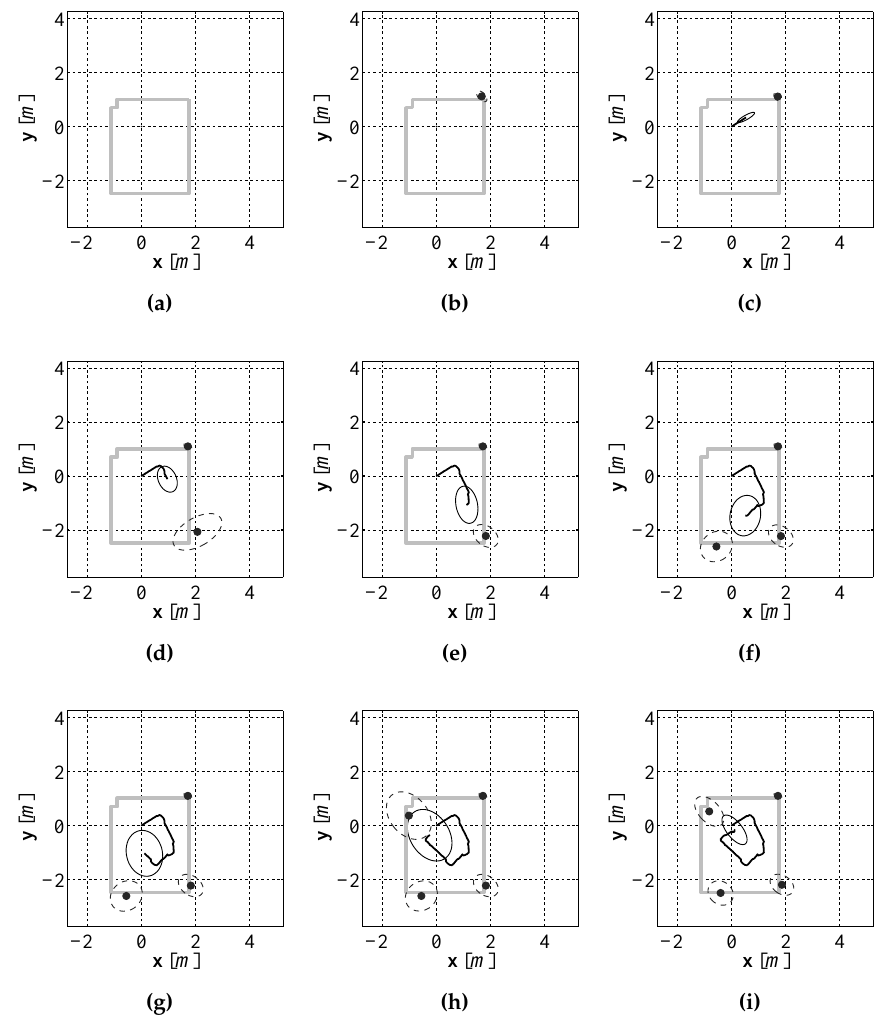
Figure 24. An evenly spaced sequence of images, ( a )–( i ), through out the entire localization and mapping